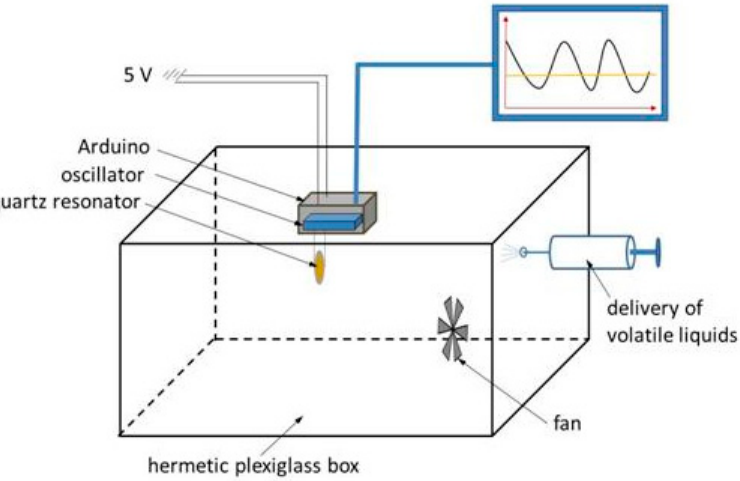
Figure 2. Box for organic compound gas measurements.